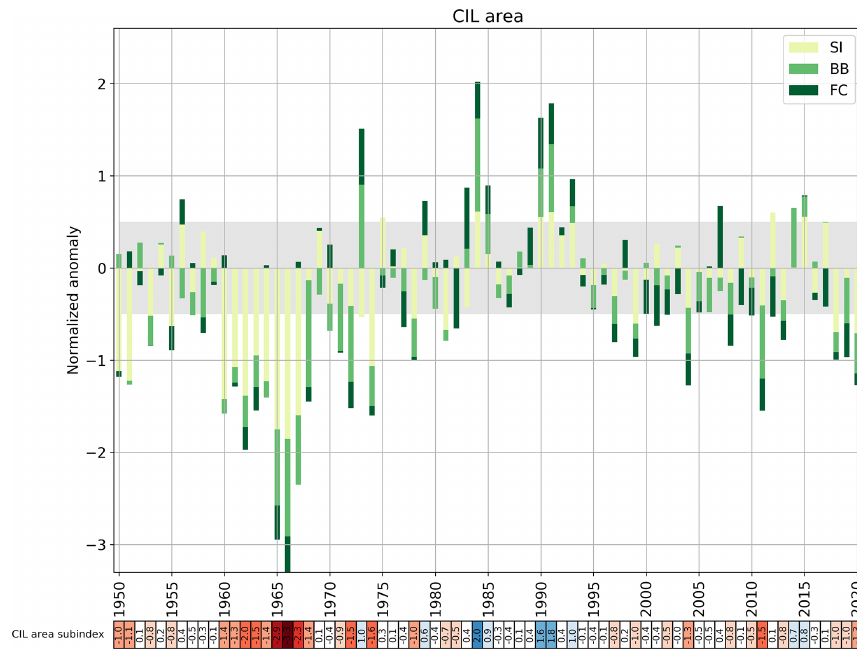
Figure A6. Same as Fig. 10 but using a climatology referenced to the 1981–2010 period.